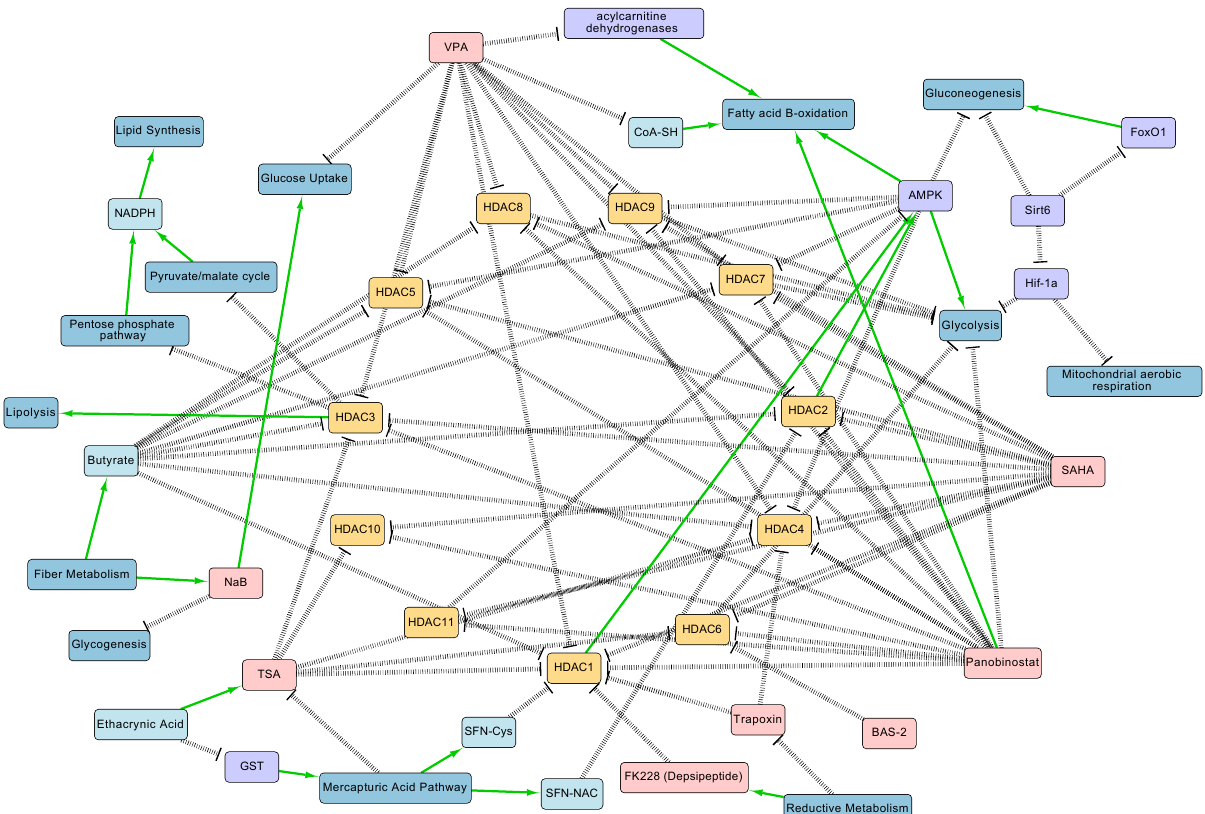
Figure 1. HDAC–metabolic interaction network diagram generated from literature curation. Salient regulatory interactions between HDACs 1-11, metabolites, and metabolic pathways are shown. Note that this diagram is not comprehensive and does not show all interactions between these processes. HDACs are represented in yellow, HDAC inhibitors in red, metabolites in light blue, metabolic pathways in dark blue, and proteins in purple. Positive regulatory arrows are depicted in green and negative regulatory arrows in black. The network map was created in Cytoscape. The figure highlights the complexity of the interactions between HDACs and metabolism, and highlights the need for systems biology approaches to study their interplay. Table 1. Table summary of common HDACIs’ isoform selectivity, structure, and connection to metabolism. Notable Structural Charac- HDACI HDAC Isoform Selectivity Metabolic Relationship Sources teristics Cyclic tetrapeptide Activity decreased by re- Trapoxin (TPX) HDAC1,4 [2,30] Epoxyketone group ductive metabolism